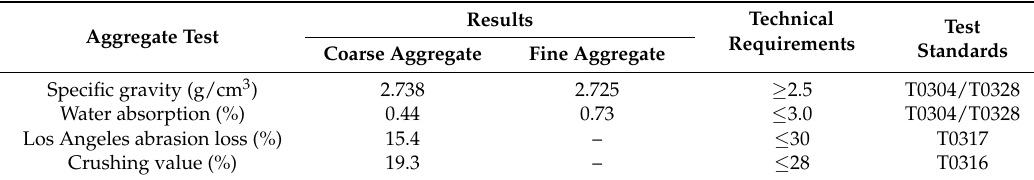
Table 2. Physical properties of coarse and fine aggregates.